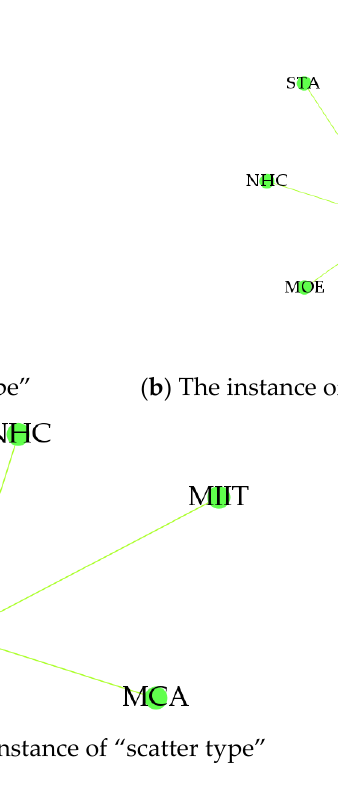
Figure 5. The node relationship figure of the in-degree. ( a ) The representative result of “wide-range connection type” (taking the MCA node as an example), ( b ) the representative result of “small-range connection type” (taking the MOF node as an example), and ( c ) the representative result of “scatter type” (taking the MEM node as an example).